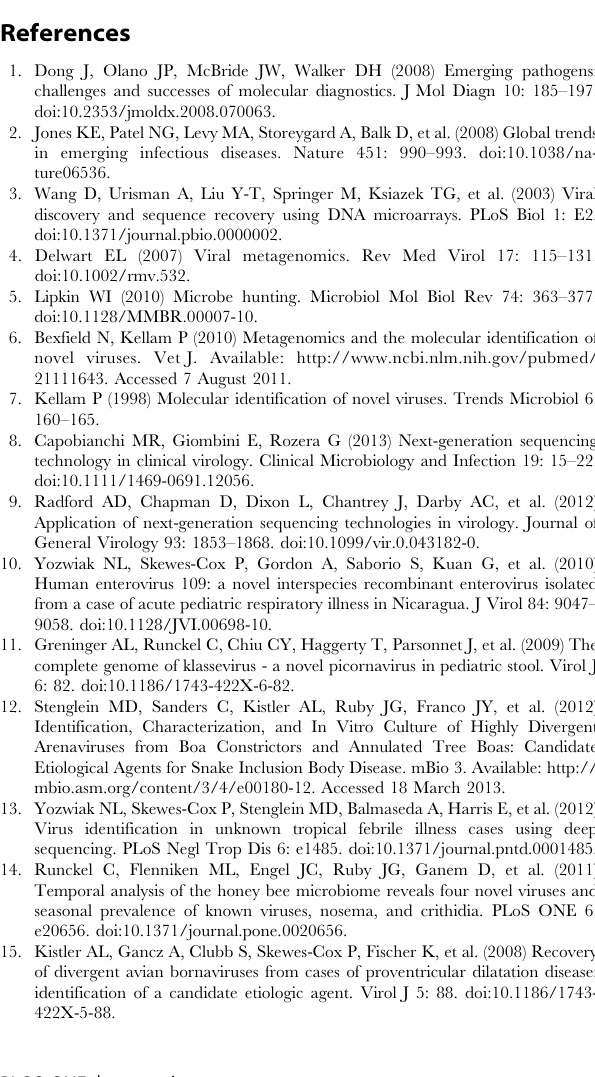
Figure S2 Histogram of vFams producing alignments in metagenomic dataset analyses. A histogram of the top 100 vFams producing alignments and the number of sequences aligned to each of these vFams from the metagenomic dataset analysis for (A) Human klassevirus 1 , (B) Santeuil nodavirus , and (C) CAS virus . Red asterisks denote the alignments for vFams containing true homologs of the virus found in the metagenomic